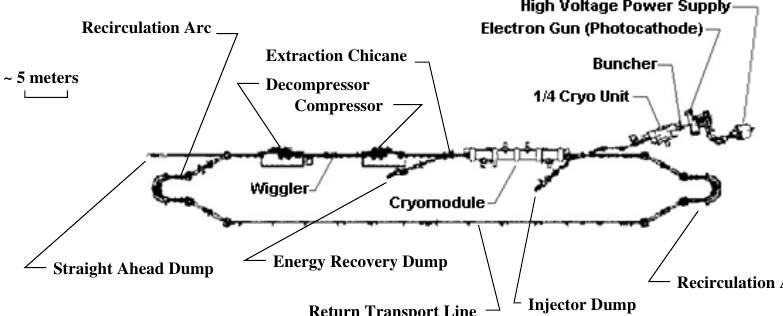
FIG. 3. Overview of the Ir-Demo free-electron laser at the Jefferson